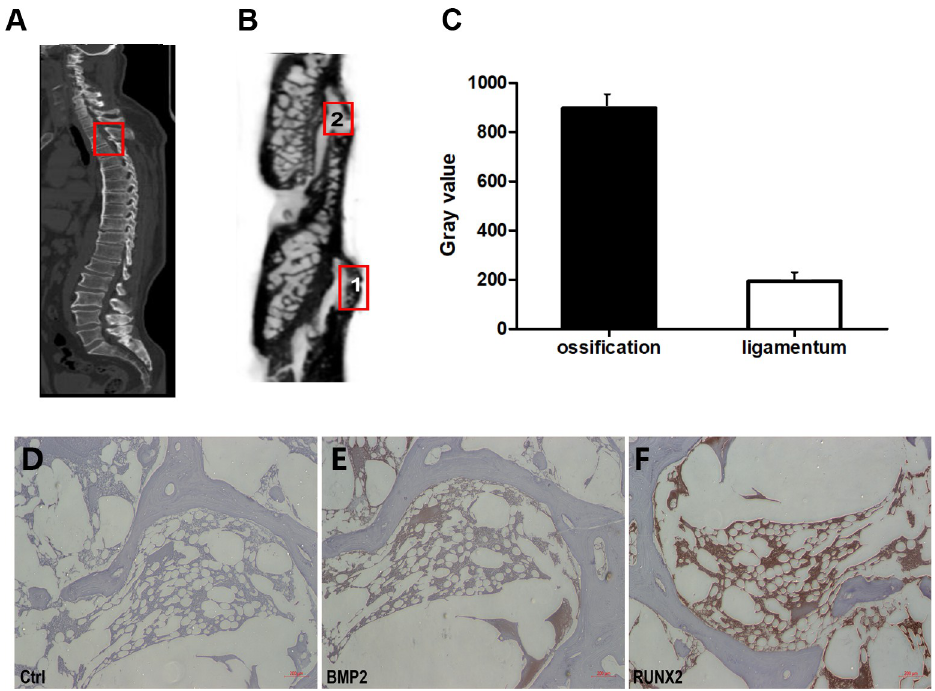
Fig 1. Characterization of properties of TOLF. A) CT image of TOLF patient. Ossified ligamentum flavum were observed. The thecal sac was compressed in TOLF; B) Micro-CT image of TOLF region after sagittal reconstruction. 1. ossified ligamentum flavum region with black color, 2. non-ossified ligamentum flavum region with white color; C) Gray value of red frame in B quantitation. Gray value represents different tissue density; (D–F), Immunohistochemical analysis of related markers expression levels in vivo in TOLF patients. Control (D, Ctrl); BMP2 (E) and RUNX2 (F).